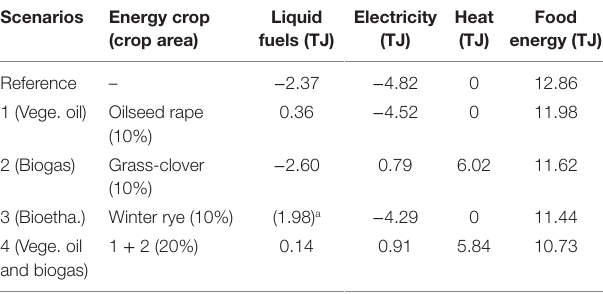
TaBle 9 | annual net output of liquid fuels, electricity, heat, and food energy for the entire system of 1000 ha in each scenario. scenarios energy crop (crop area)